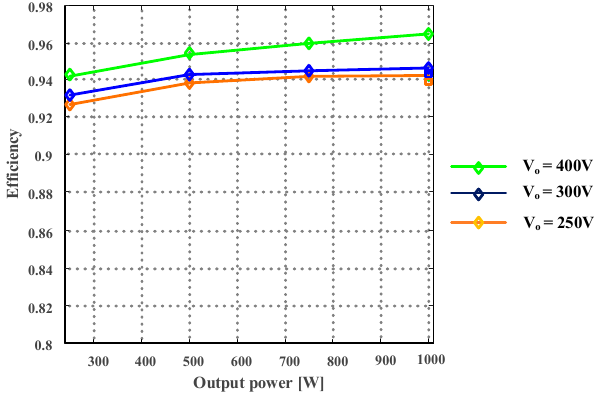
Figure 11. D Vgs5 = 1, R L = 100 ohm, Vo = 440 V, f s = 85 kHz.